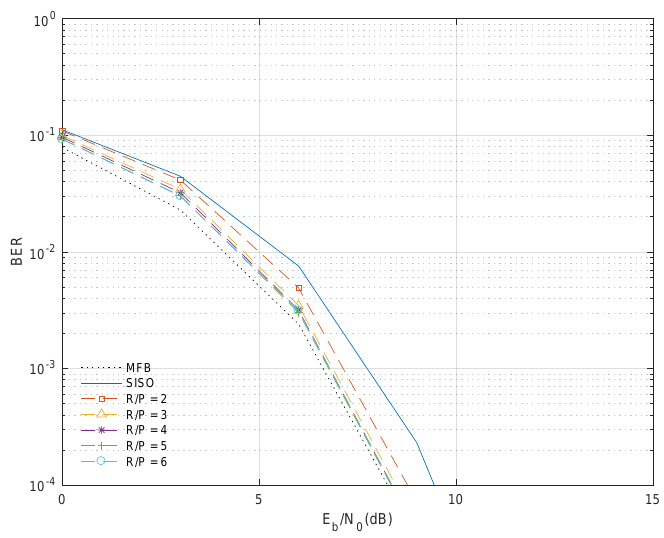
Figure 4. Theoretical BER performance for the third iteration when using IB-DFE for different R / P values.